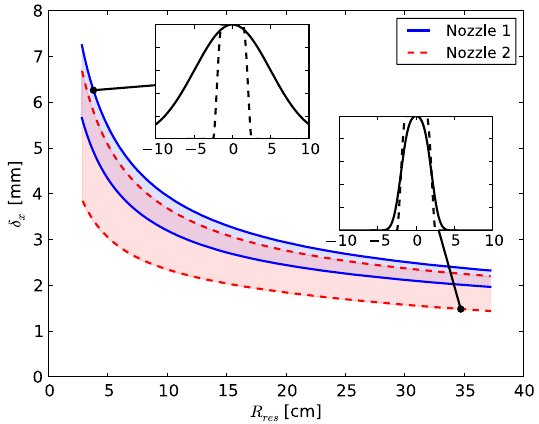
FIG. 10. Horizontal lateral penumbra at the focal point (in air) vs residual beam range in water for Nozzle 1 and Nozzle 2, proton beams. Upper lines corresponds to 65 cm air gap, lower lines to 10 cm air gap, and colored bands intermediate values. Insets show two examples of scattered (solid line) and pristine (dashed line) transverse beam profile.